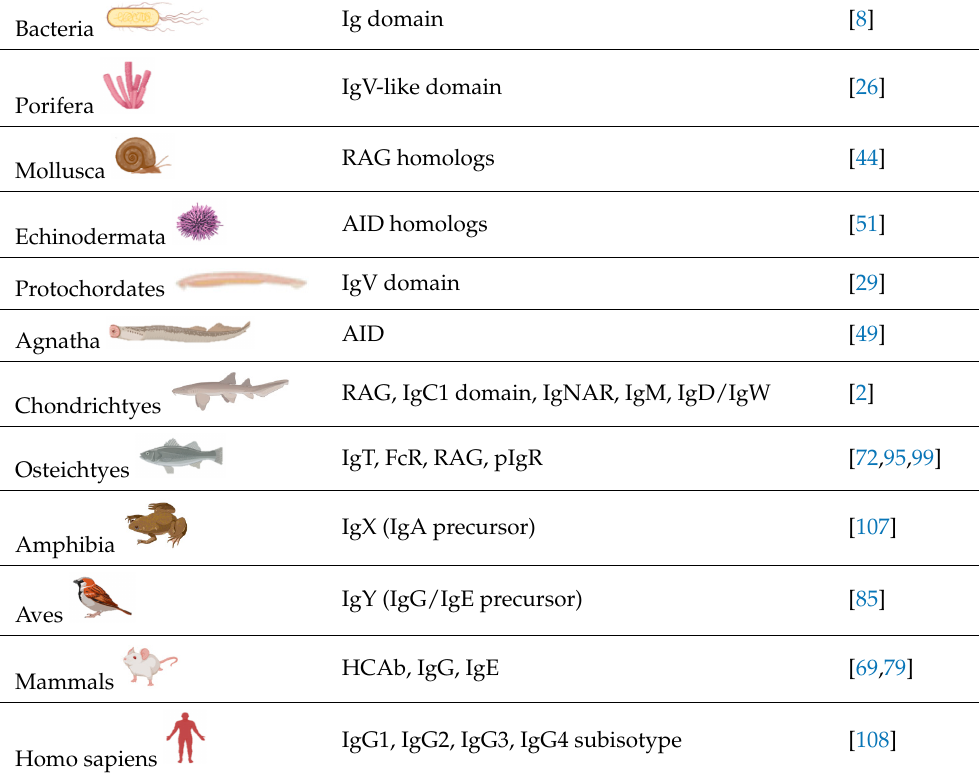
Table 1. Summary of the emergence in different Phyla of the key elements related to the evolution of antibody. Ig: immunoglobulin; IgV: immunoglobulin variable domain; IgC1: immunoglobulin- constant-region-type 1 domain; RAG: recombination activating genes; AID: activation-induced cytidine deaminase; FcR: crystallizable fragment receptor; pIgR: polymeric Ig receptor. Reference corresponding to each key element is reported in the right-hand column.